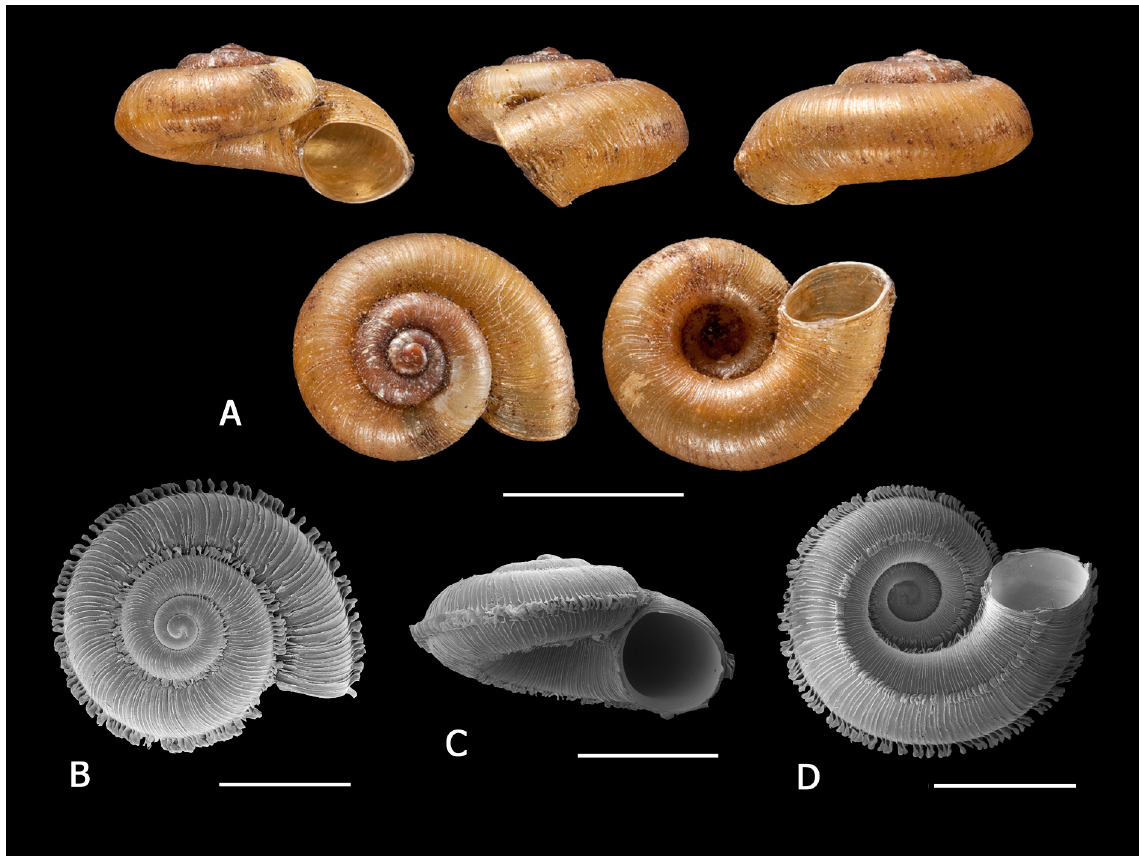
Fig. 22. Chondrocyclus putealis Connolly, 1939. A . Syntypes (NHMUK 1937.12.30.5087– 1937.12.30.5090). B–D . ELM W3656. B . Aperture view. C . Dorsal view. D . Ventral view. Scale bars: A = 3 mm; B–D = 2